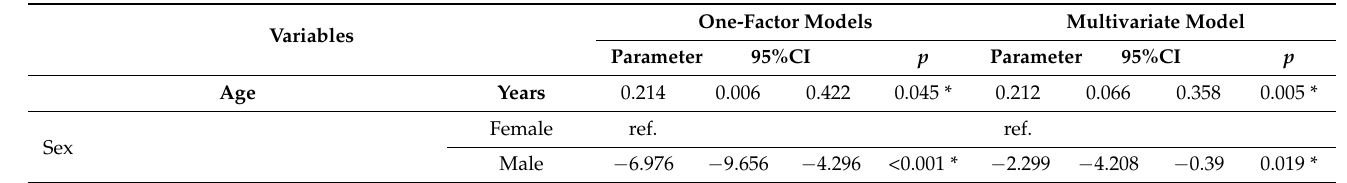
Table 5. Factors influencing attitudes towards vaccination (VAX scale). Single and multivariate linear regression